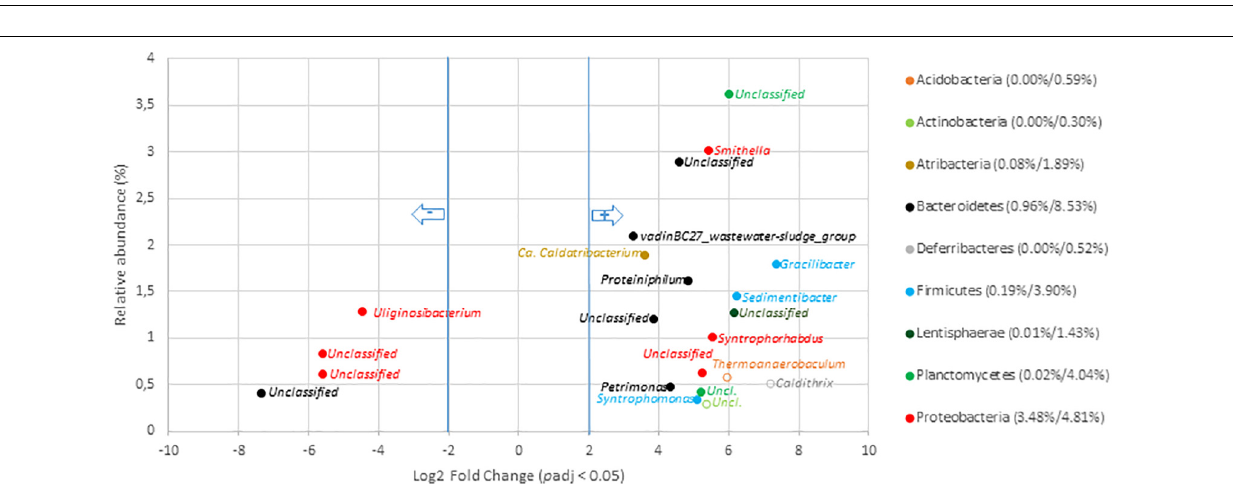
FIGURE 4 | Genera with significant changes in relative abundance after anaerobic digestion of raw organic waste samples from agricultural and central mixed origin. Genera with significant ( p adj < 0.05) decrease in digestates compared to raw OW samples (left part of the plot) are presented according to their initial relative abundance in raw OW. Genera with significant increase in digestates compared to raw OW samples (right part of the plot) are presented according to their relative abundance in digestate. Genera are colored according to the phylum to which they belong. Full mark represents genus present in the core microbiome; empty mark represents genus not present in the core microbiome (raw OW and digestate core microbiomes were, respectively, considered at the left and right part of the plot). Numbers in brackets represent the sum at the phylum level of relative abundances of all genera with significant change after AD calculated before and after AD (raw OW%/digestate%). Only genera with relative abundance ≥ 0.3% and significant change (-2 ≥ Log2 FC ≥ +2, p adj < 0.05, minimum normalized read count = 10) are shown (see Supplementary Table 10 for the other groups).